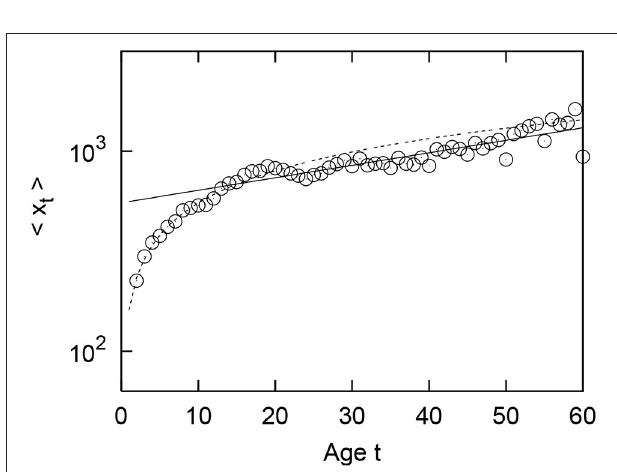
FIGURE 3 | Dependence of geometric mean of Japanese firms’ sales h x t i in 2014 on firm age t